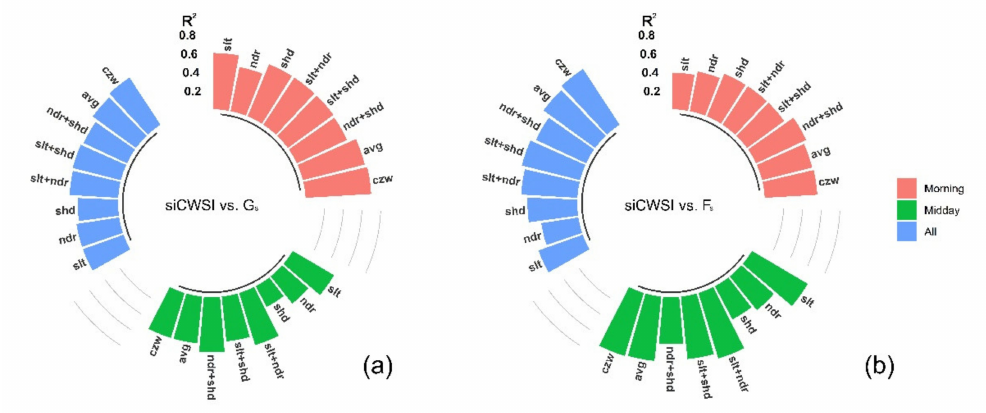
Figure 13. Circular bar plots show the relationships (R 2 ) established between siCWSI from di ff erent canopy zones and stomatal conductance (G s , ( a )) and steady-state fluorescence (F s , ( b )) for the two thermal flights on 19 September 2018 and all flights combined. slt is for sunlit canopy zone, ndr is for nadir canopy zone, shd is for shaded canopy zone, avg is for average value of entire canopy zone, and CZW is for canopy zone-weighting